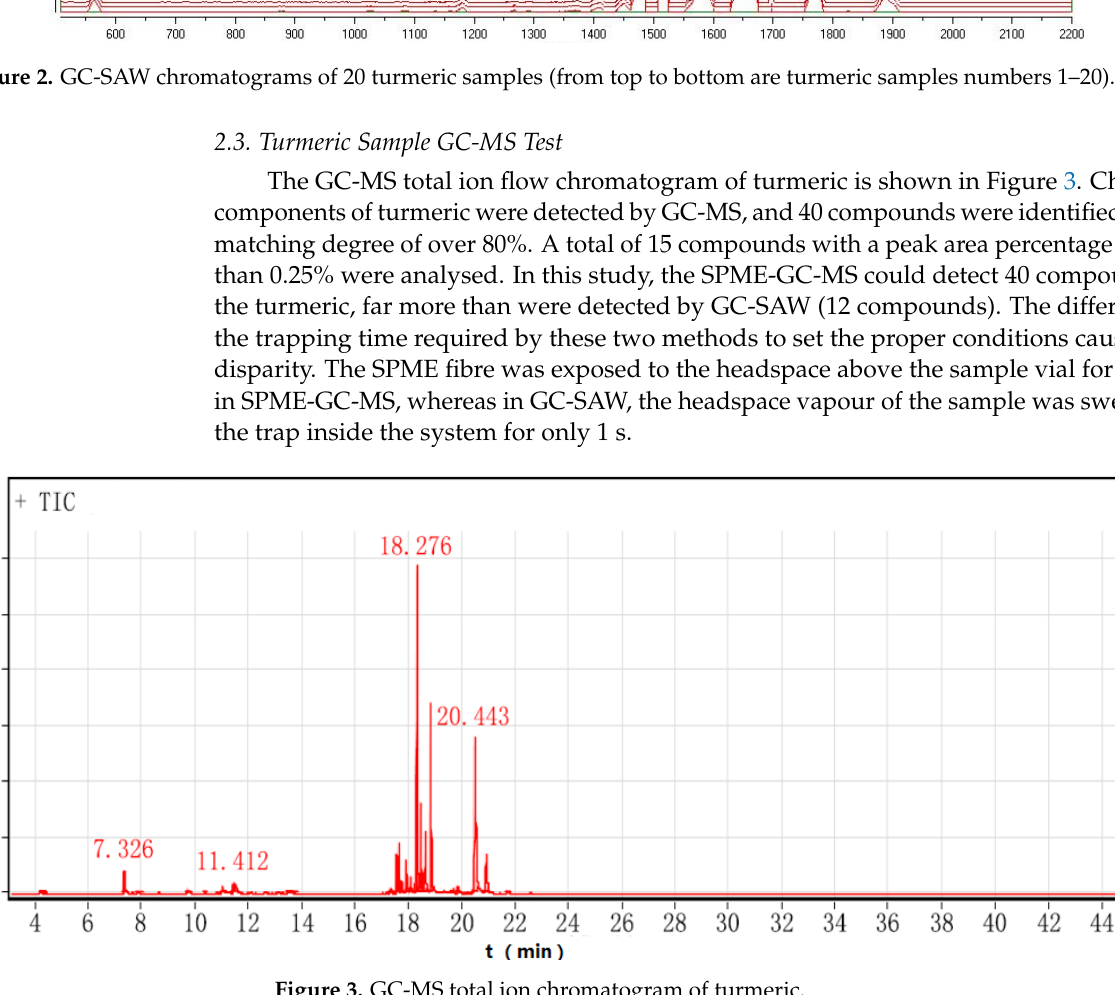
Figure 3. GC-MS total ion chromatogram of turmeric.